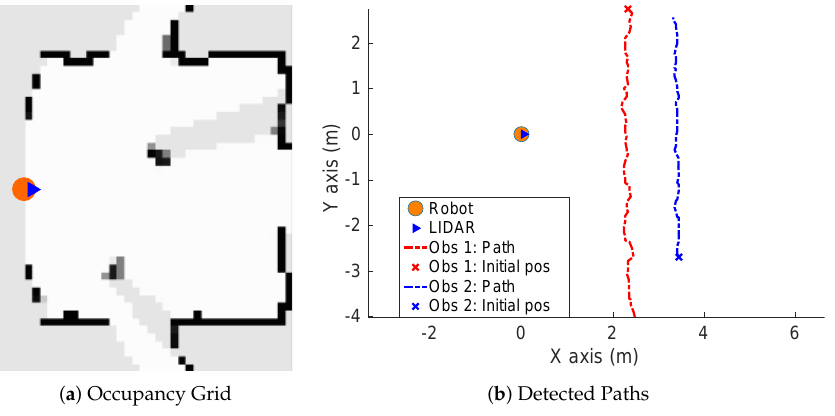
Figure 12. Real scenario 1—Occupancy Grid and Paths detected.